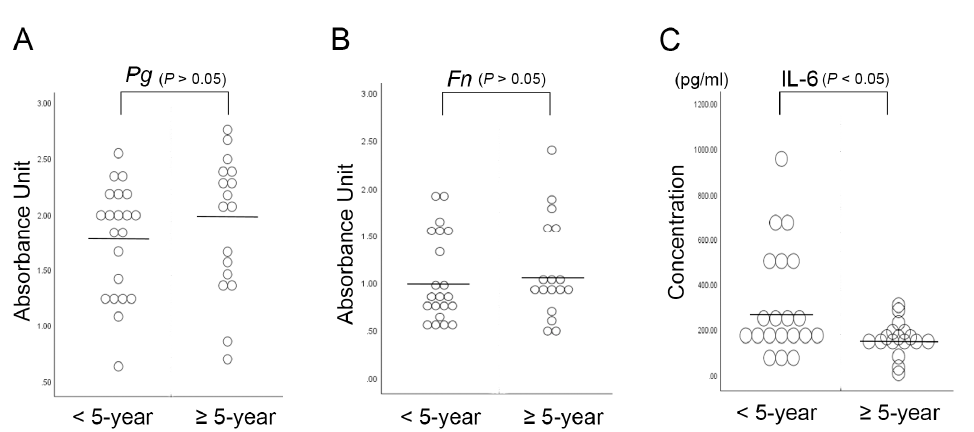
Figure 4. Serum P. gingivalis IgG and F. nucleatum values and serum IL ‐ 6 values in OSCC